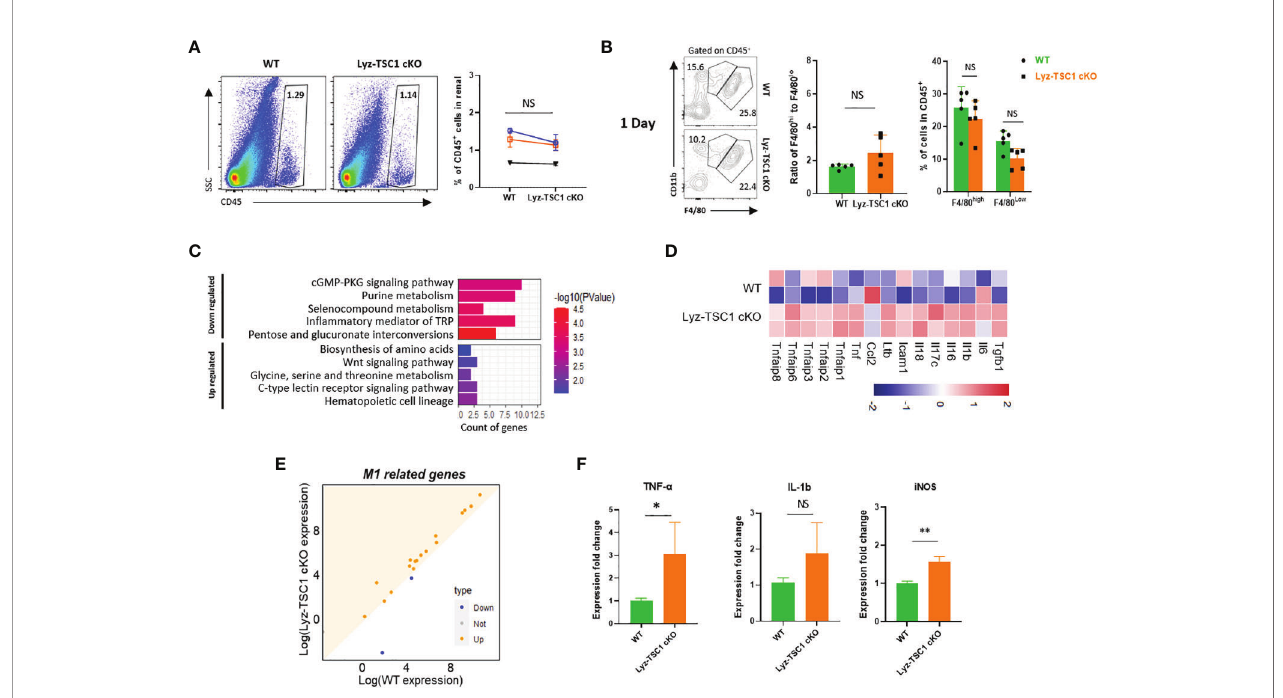
FIGURE 2 | Increased M1 polarization of TSC1 knockout macrophages during the early phase. (A) In fl ammatory cell in fi ltration and percentage of CD45 + cells in WT and Lyz-TSC1 cKO kidneys on day 1 after reperfusion. (B) F4/80 high macrophages and F4/80 low macrophages from WT and Lyz-TSC1 cKO mice gated on CD45 + cells. (C) Histogram of the top 10 most up- and downregulated KEGG pathways. (D) Dot plot of M1-related genes. The orange color represents the upregulated genes in the Lyz-TSC1 cKO macrophages. (E) Heatmap of up- and downregulated M1-related genes in the WT and Lyz-TSC1 cKO groups. (F) Relative mRNA expression of interleukin -1 b (IL-1 b ), tumor necrosis factor- a (TNF- a ), and iNOS in kidney macrophages sorted from WT and Lyz-TSC1 cKO mice 24 h after IRI. In (A , B , F) , the data are shown as the mean ± SD and were analyzed by an unpaired two-tailed Student ’ s t-test (n ≥ 3). *P < 0.05; **P < 0.01; NS, not signi fi